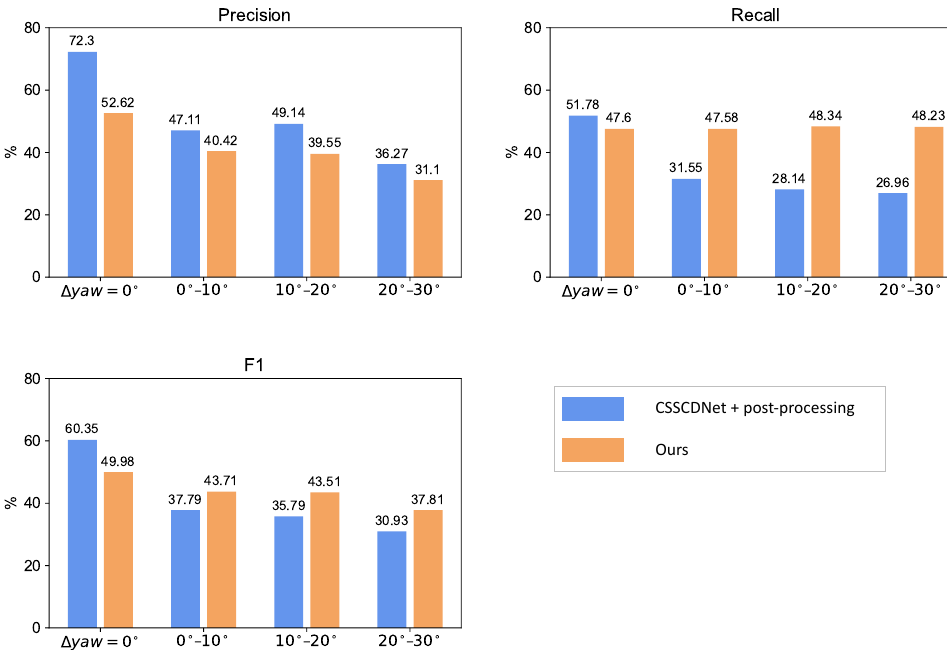
Figure 9. The precision, recall and F 1 scores of our proposed network and the existing methods [18] for the separate scales of viewpoint differences between the